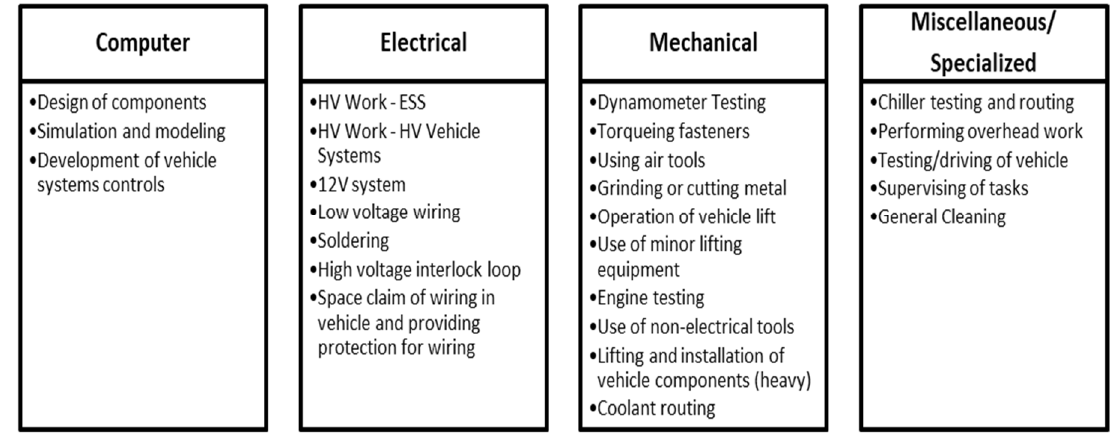
Figure 7. List of Potential UWAFT Tasks.